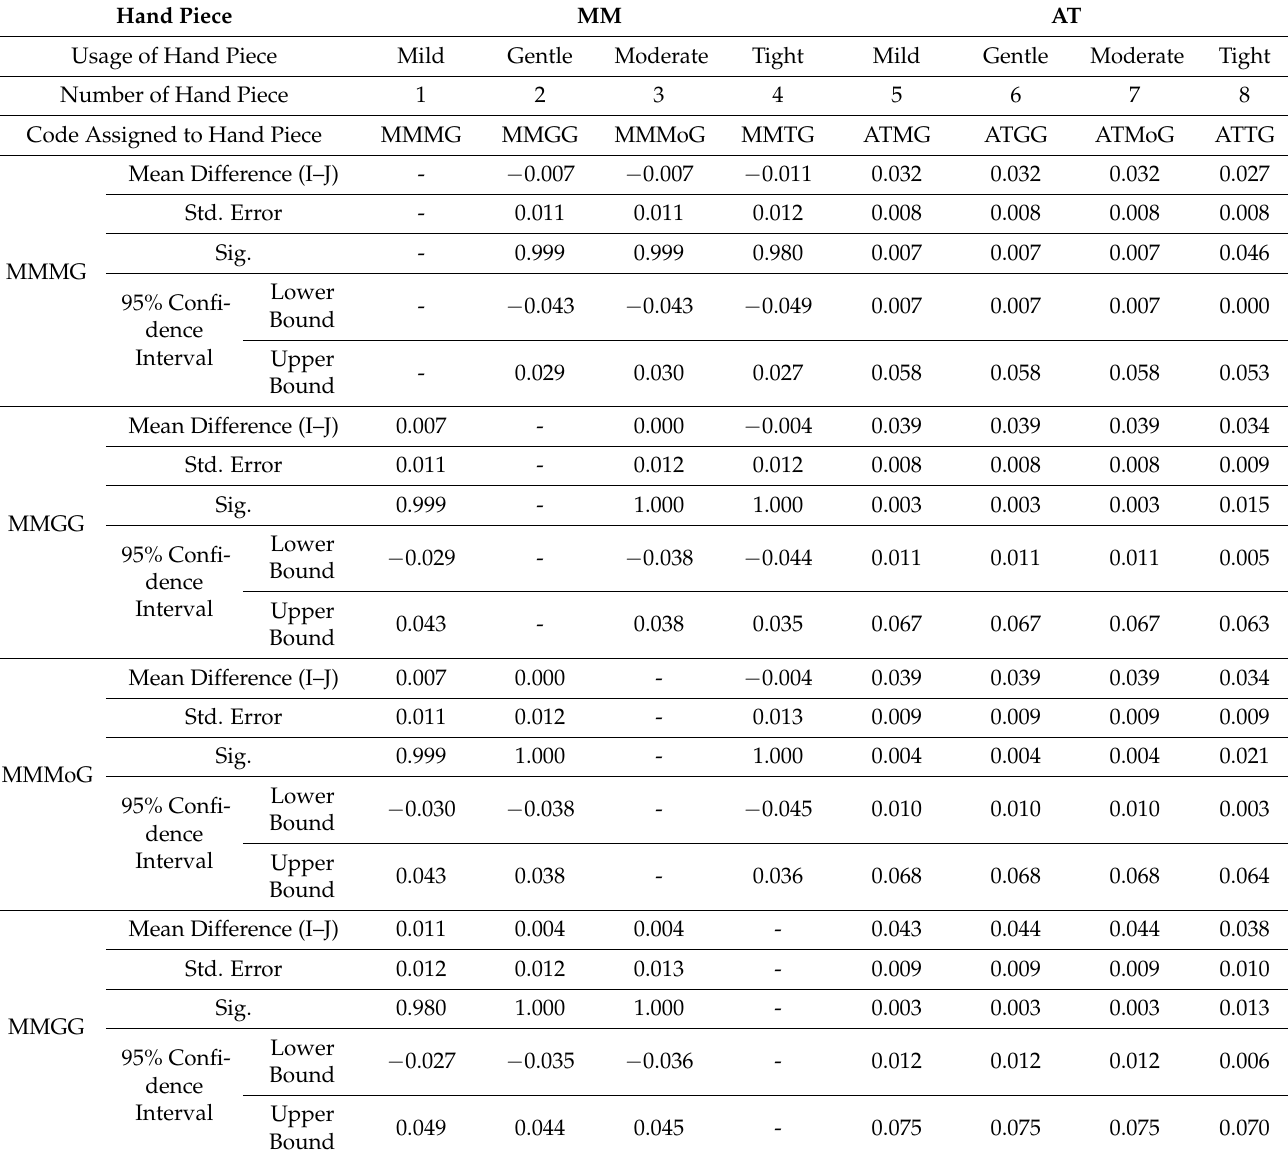
Table 8. Post hoc analysis for various grasping conditions in two different hand